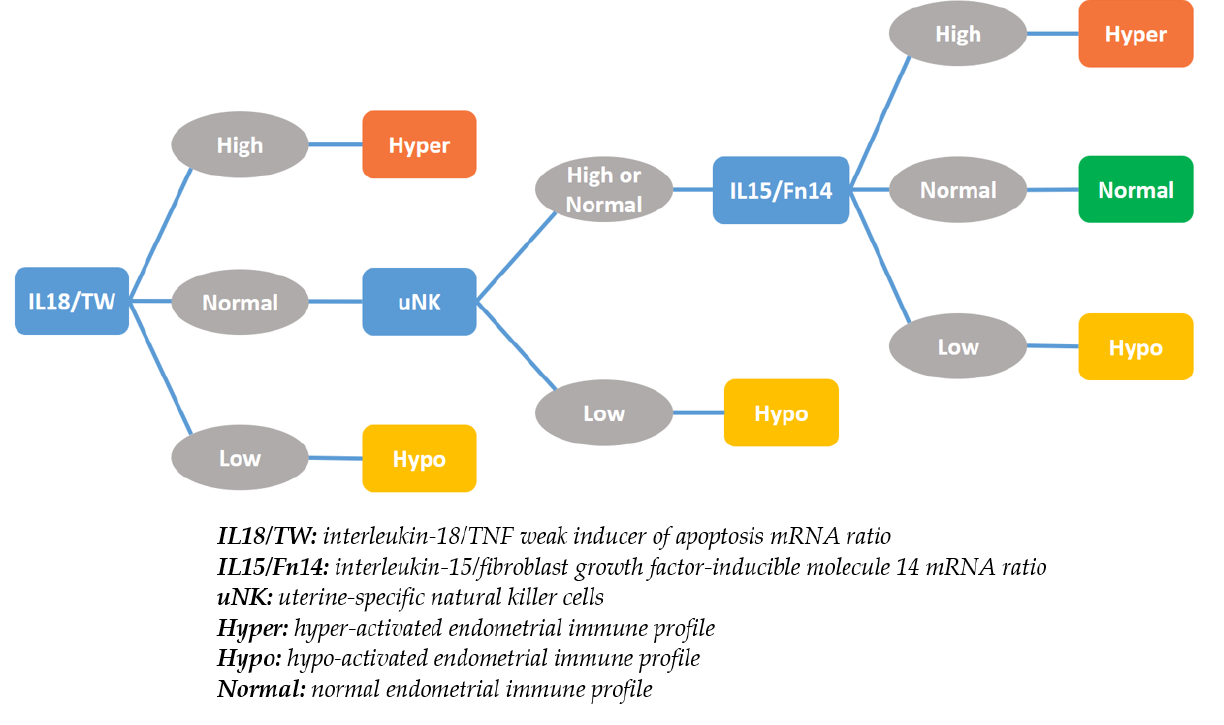
Figure 1. Decision tree for the interpretation of immune deregulation, according to Lédée et al. [24] .